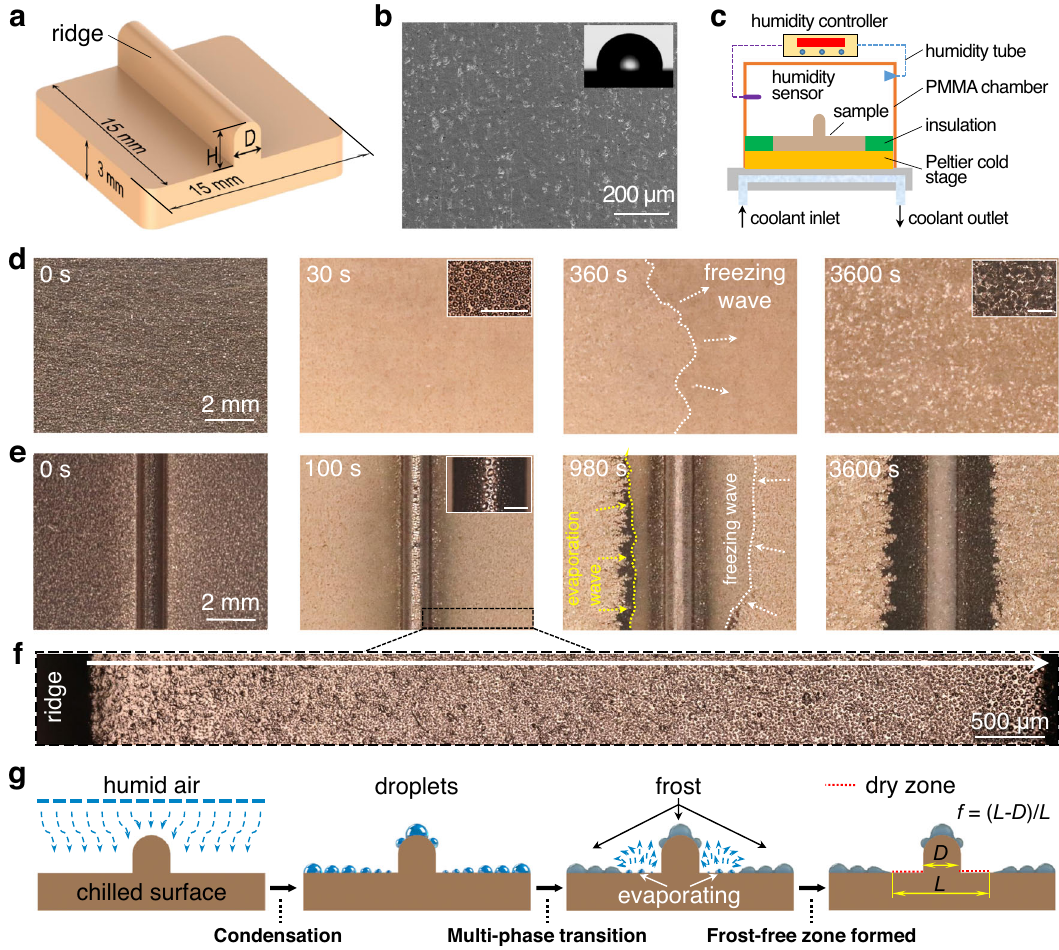
Fig. 1 Condensation frosting on the surface. a Schematic showing the parameters of the macro-ridged surface. b Scanning electronic micrograph (SEM) image of the surface. The inset shows a contact angle of ~100 ∘ with a 3 μ L drop. c Schematic showing the setup for condensation frosting experiments. d Condensation frosting on a fl at surface. The insets show the high magni fi cation optical images of the condensates at 30 s and frost at 3600 s, respectively. Scale bar, 300 μ m. e Condensation frosting on the macro-ridged surface H3D1. The inset shows the high magni fi cation optical image of droplets on the top of ridge at 100 s. White dotted line indicates the propagation of freezing wave and yellow dotted line indicates evaporation wave in the multi-phase transition stage. Scale bar, 300 μ m. f Gradient distribution of condensate droplets on the macro-ridged surface. g Schematic showing the frost- free zone formation at different stages on a macro-ridged